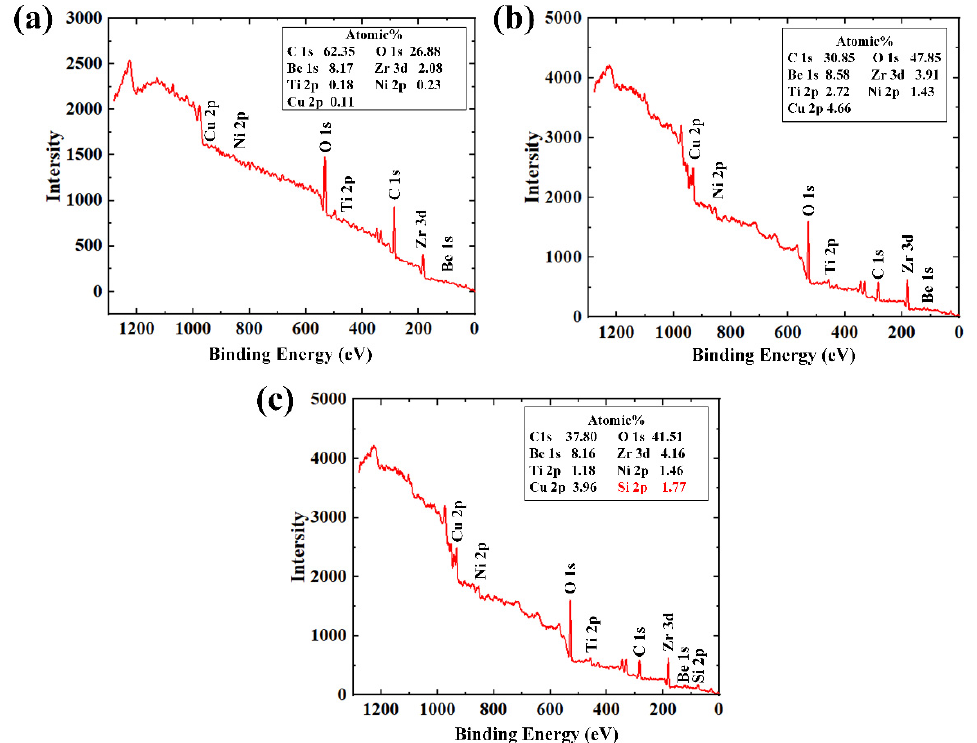
Figure 9. XPS full spectra of ( a ) untreated BMG surface; ( b ) laser textured BMG surface; ( c ) laser textured BMG surface followed by heat treatment.